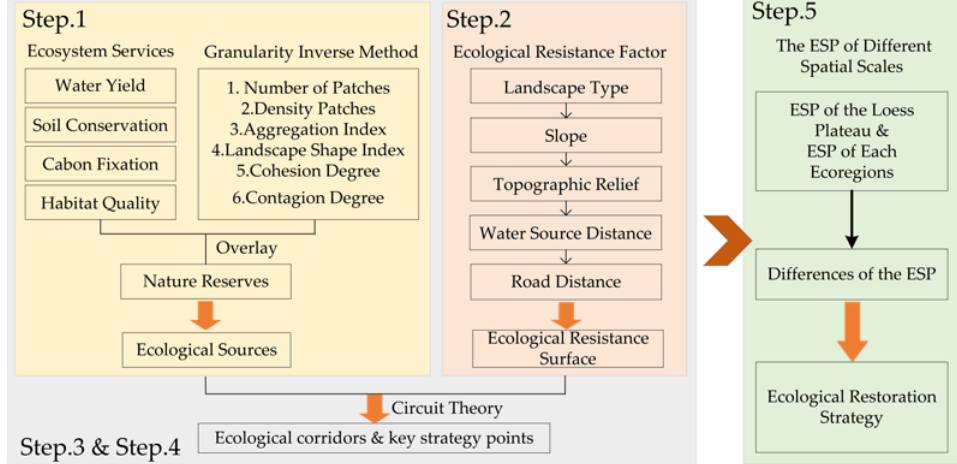
Figure 2. Framework for identifying key areas of ecological conservation and restoration.